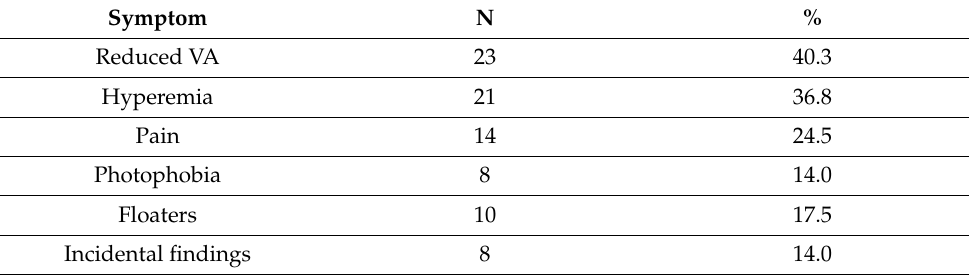
Table 5. Symptoms at the onset of infectious